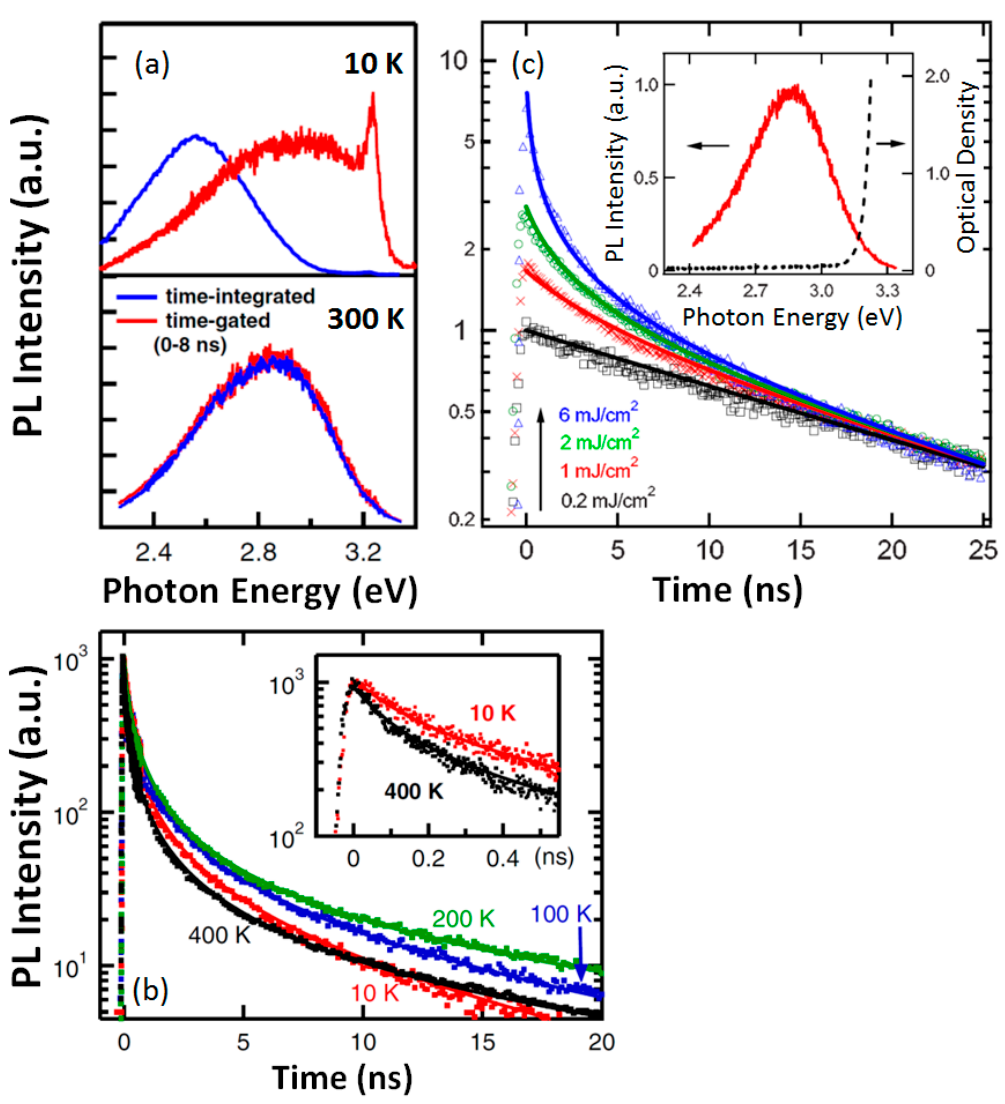
Figure 4. ( a ) Time-gated (0–8 ns) and time integrated photoluminescence (PL) spectra at 10 and 300 K, ( b ) PL decay curves at 10, 100, 200, and 400 K. The inset shows a more detail of PL decay profiles in the sub-nanosecond region at 10 and 400 K, ( c ) PL decay dynamics at different excitation densities. Solid lines fit to the data using Equation (1) from [24]. The inset shows the PL spectrum under 0.02 mJ/cm 2 laser irradiation (solid line) and the absorption spectrum (dashed line). In ( a , b ) PL spectra were acquired under an excitation density of 8.9 mJ/cm 2 . In the ordinate axis, a.u. stands for “arbitrary units”. Figure 4a,b are reprinted with permission from [28] Copyright (2009) by the American Physical Society. Figure 4c is reprinted with permission from [24] Copyright (2008) by the American Physical Society.